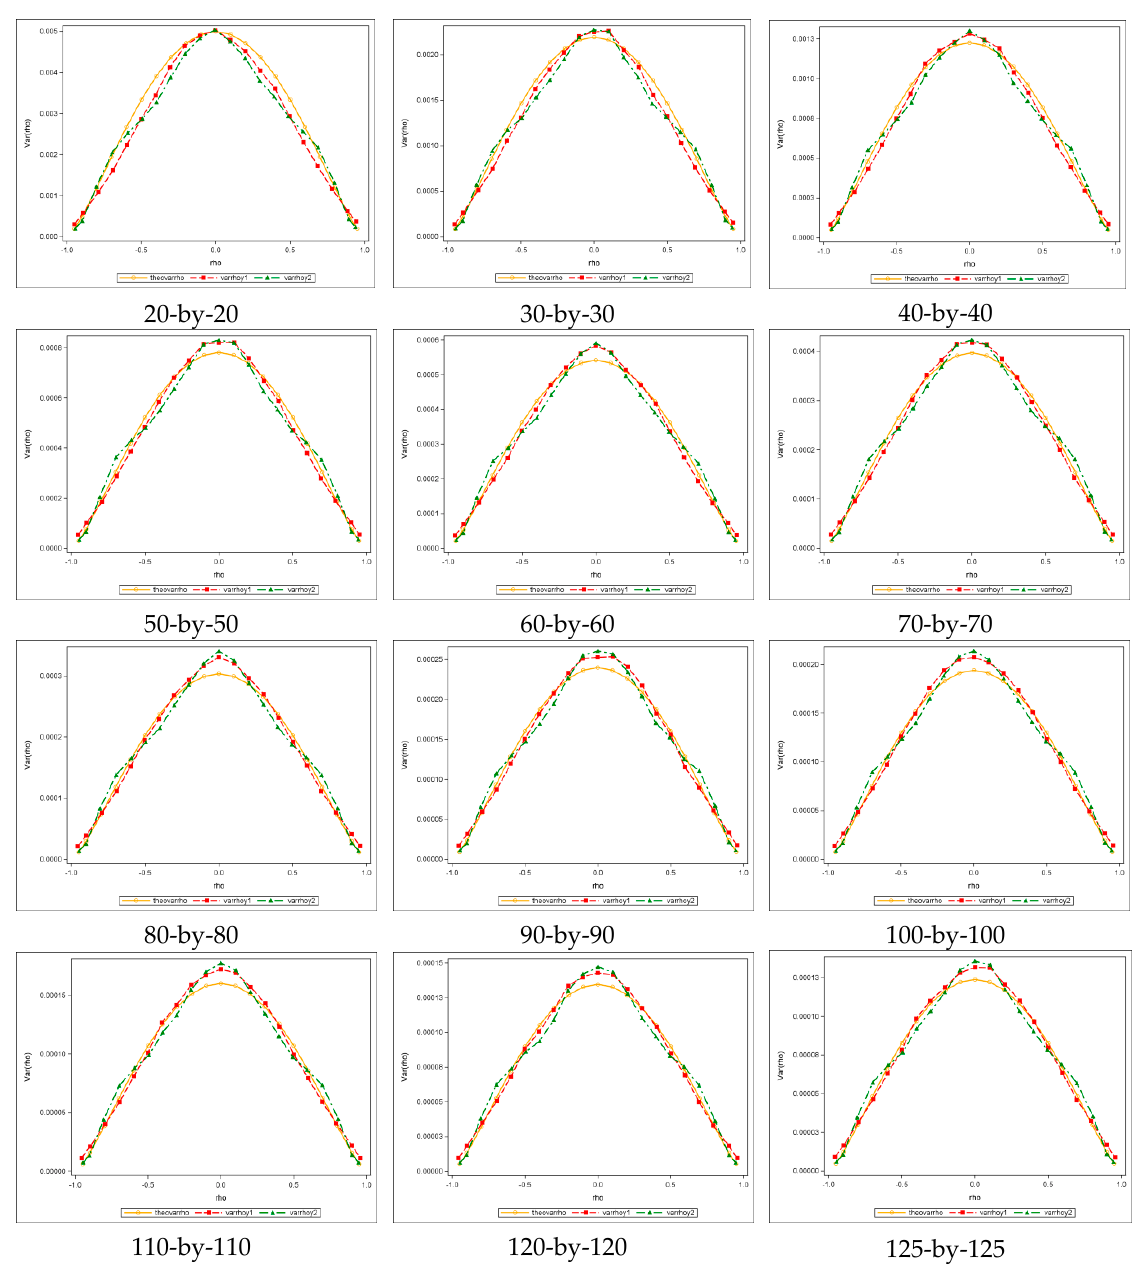
Figure A4. Theoretical variances (orange) versus exact variances (red and green) obtained by approximating the Jacobian term and employing new maximum likelihood estimators (MLEs) with different sample sizes for the square tessellation with rook adjacency.